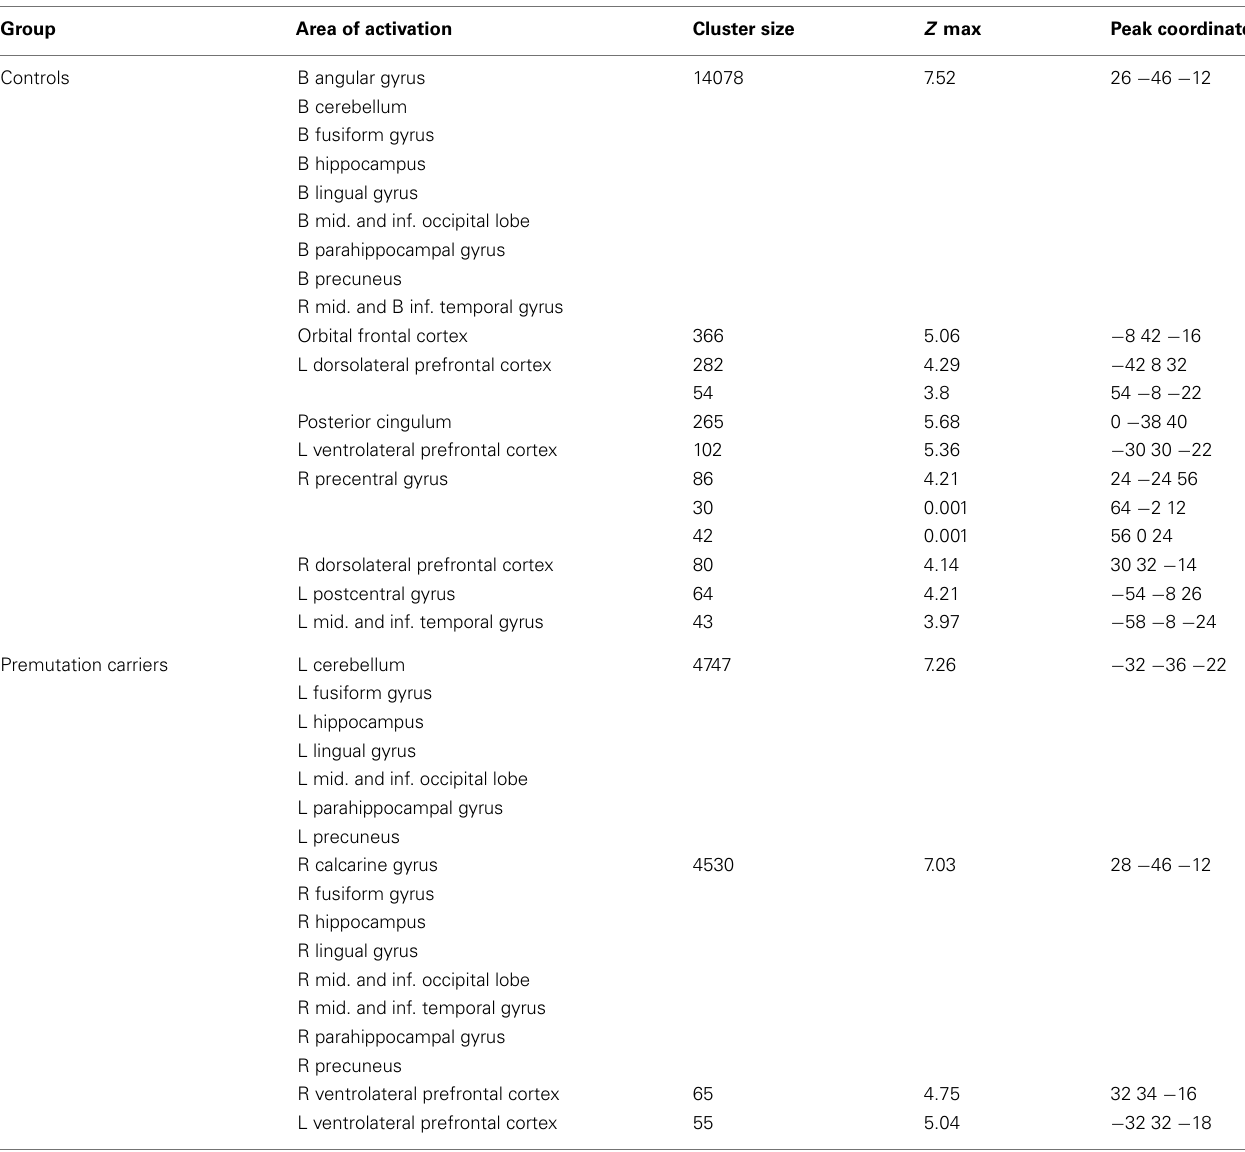
Table 3 |Within-group activation data for both premutation carriers and control group on the whole-brain level for the encoding > scrambled